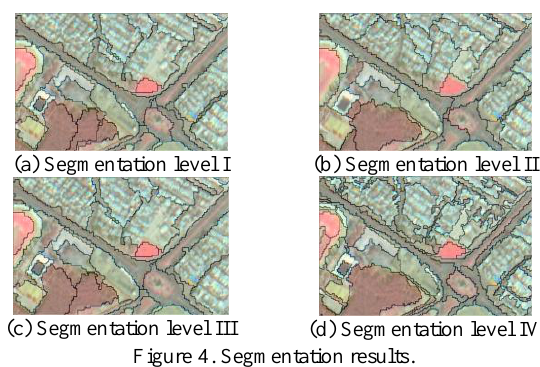
Figure 4. Segmentation results.